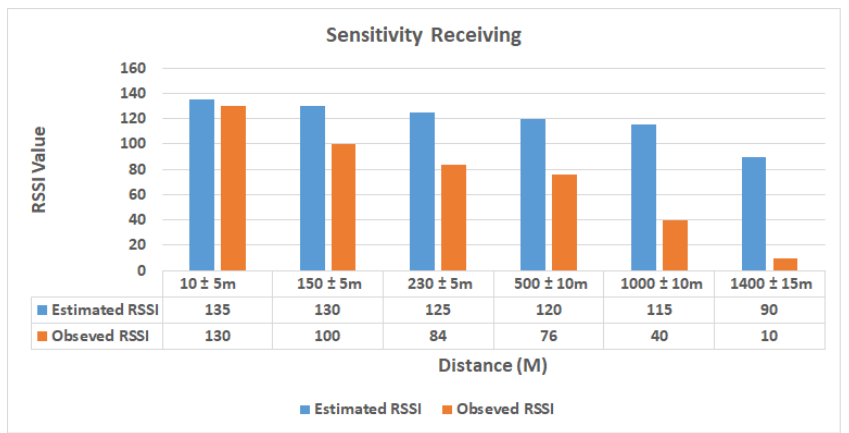
Figure 19. The Actual Results of Sensitivity